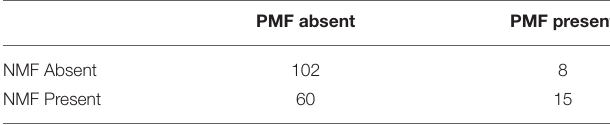
TABLE 1 | Count of trials with and without positive and negative behavioral